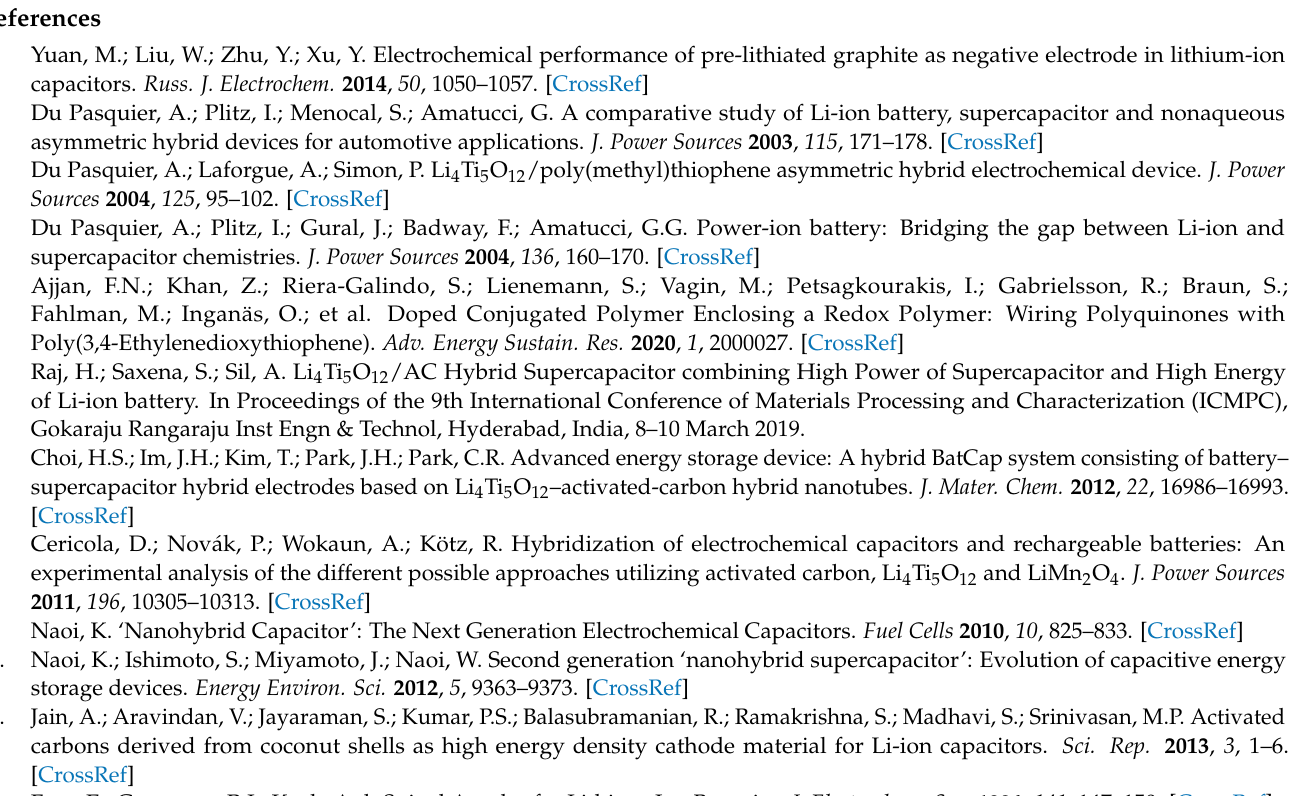
for 60 days, Figure S2: GC raw data (organic part) of AN-based LIC after rest at 55 ◦ C for 60 days, Figure S3: GC raw data (inorganic part) of ester-based LIC after rest at 55 ◦ C for 60 days, Figure S4: GC raw data (organic part) of ester-based LIC after rest at 55 ◦ C for 60 days, Figure S5: GC raw data (inorganic part) of AN-based LIC after rest at 25 ◦ C for 60 days, Figure S6: GC raw data (organic part) of AN-based LIC after rest at 25 ◦ C for 60 days, Figure S7: GC raw data (inorganic part) of ester-based LIC after rest at 25 ◦ C for 60 days, Figure S8: GC raw data (organic part) of ester-based LIC after rest at 25 ◦ C for 60 days, Figure S9: GC raw data (inorganic part) of AN-based LIC after 900 cycles, Figure S10: GC raw data (organic part) of AN-based LIC after 900 cycles, Figure S11: GC raw data (inorganic part) of ester-based LIC after 900 cycles, Figure S12: GC raw data (organic part) of ester-based LIC after 900 cycles, Figure S13: calibration curves (inorganic part) of GC test, Figure S14: calibration curves (organic part) of GC test, Table S1: The comparison on electrochemical performance among this study and obtained